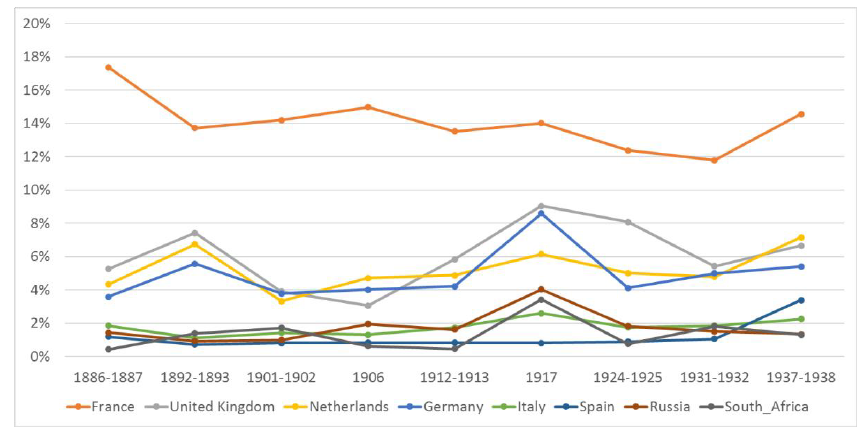
Most frequent countries of origin in Vooruit throughout the years (excluding